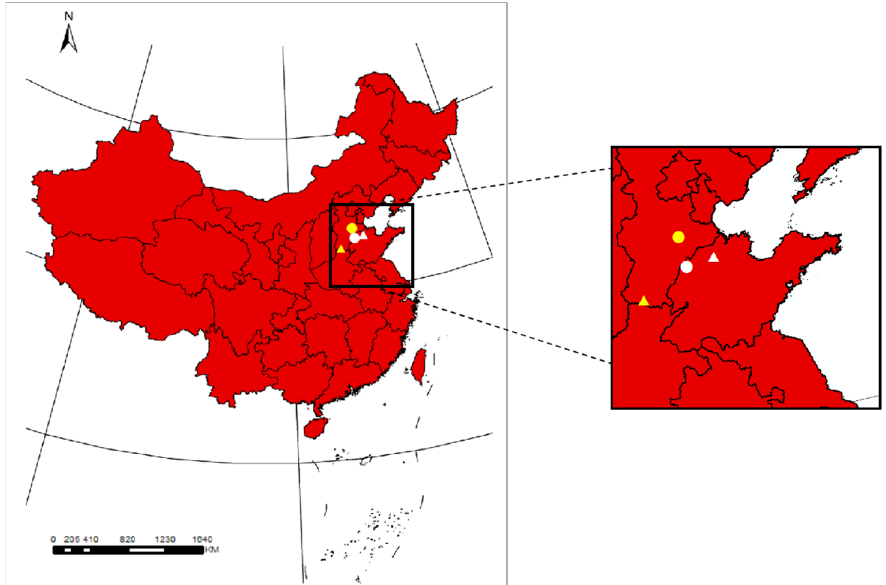
Figure 1. Location of the experiment sites. Yellow point and yellow triangle represent Hejian and Handan, Hebei Province; white point and white triangle represent Dezhou and Binzhou, Shandong Province. Table 1. Major agronomic practices for cotton production in the study locations.